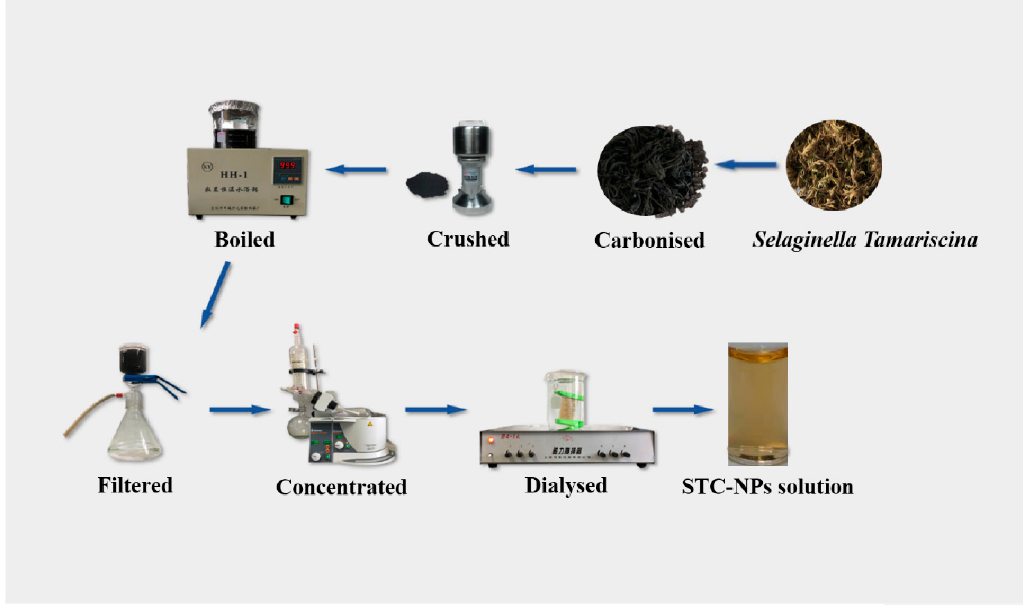
Figure 8. Flow diagram of the STC ‐ NPs preparation process.